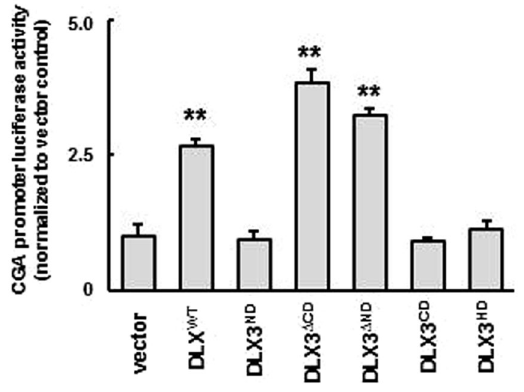
Figure 5. The DLX3 HD and either ND or CD contain transactivation activities. The CGA gene promoter has been shown to be transactivated by murine DLX3 and CGA gene promoter luciferase reporter assays were performed in JEG-3 cell to assess transactivation activities of regions of the human DLX3 protein. JEG-3 cells were transfected with DLX3 structural domain expression plasmids (1 µ g) and CGA promoter luciferase reporter plasmid (0.2 µ g) for 48 h followed by 10 μ M MG-132 treatment for 6 h, and collected for luciferase assays. Luciferase activity is normalized to protein concentration and the vector control. Results are depicted as mean ± standard error (SEM) of triplicates from an individual representative of three independent experiments. Asterisks denote a statistically significant difference compared with the vector control and DLX3 WT , respectively. * P < 0.05, ** P < 0.01 by one-way ANOVA followed by the Student’s t